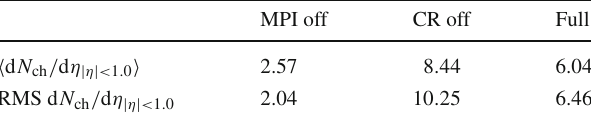
Fig. 1 Charged-particle multiplicities at mid-rapidity | η | < 1 for non- √ s = 13 TeV in PYTHIA8 with default diffractive pp collisions at settings, CR off, and MPI off Table 1 Mean and RMS values of the charged-particle multiplicities